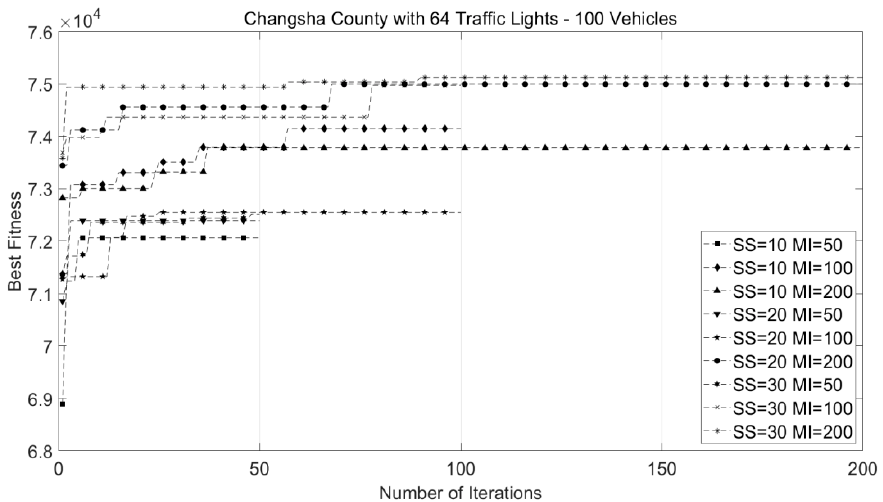
Figure 6. Traces of progress track of best fitness values of CRO-CPSO in the case of Changsha County. SS = swarm size, MI = maximum iteration.